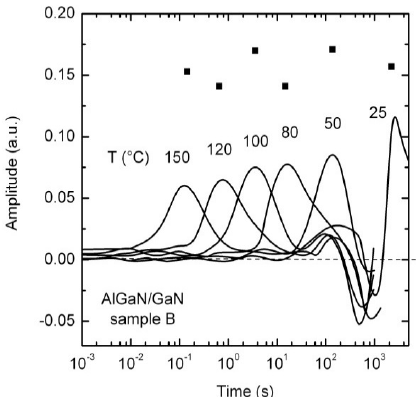
Figure 5. Time constant spectrum of an AlGaN/GaN SD structure (Sample B, V = − 6 V) evaluated by a fitting of the current transients by 70 exponentials. For comparison, data of A i vs. τ i obtained from simple three-exponential fitting (full square marks) are also shown.